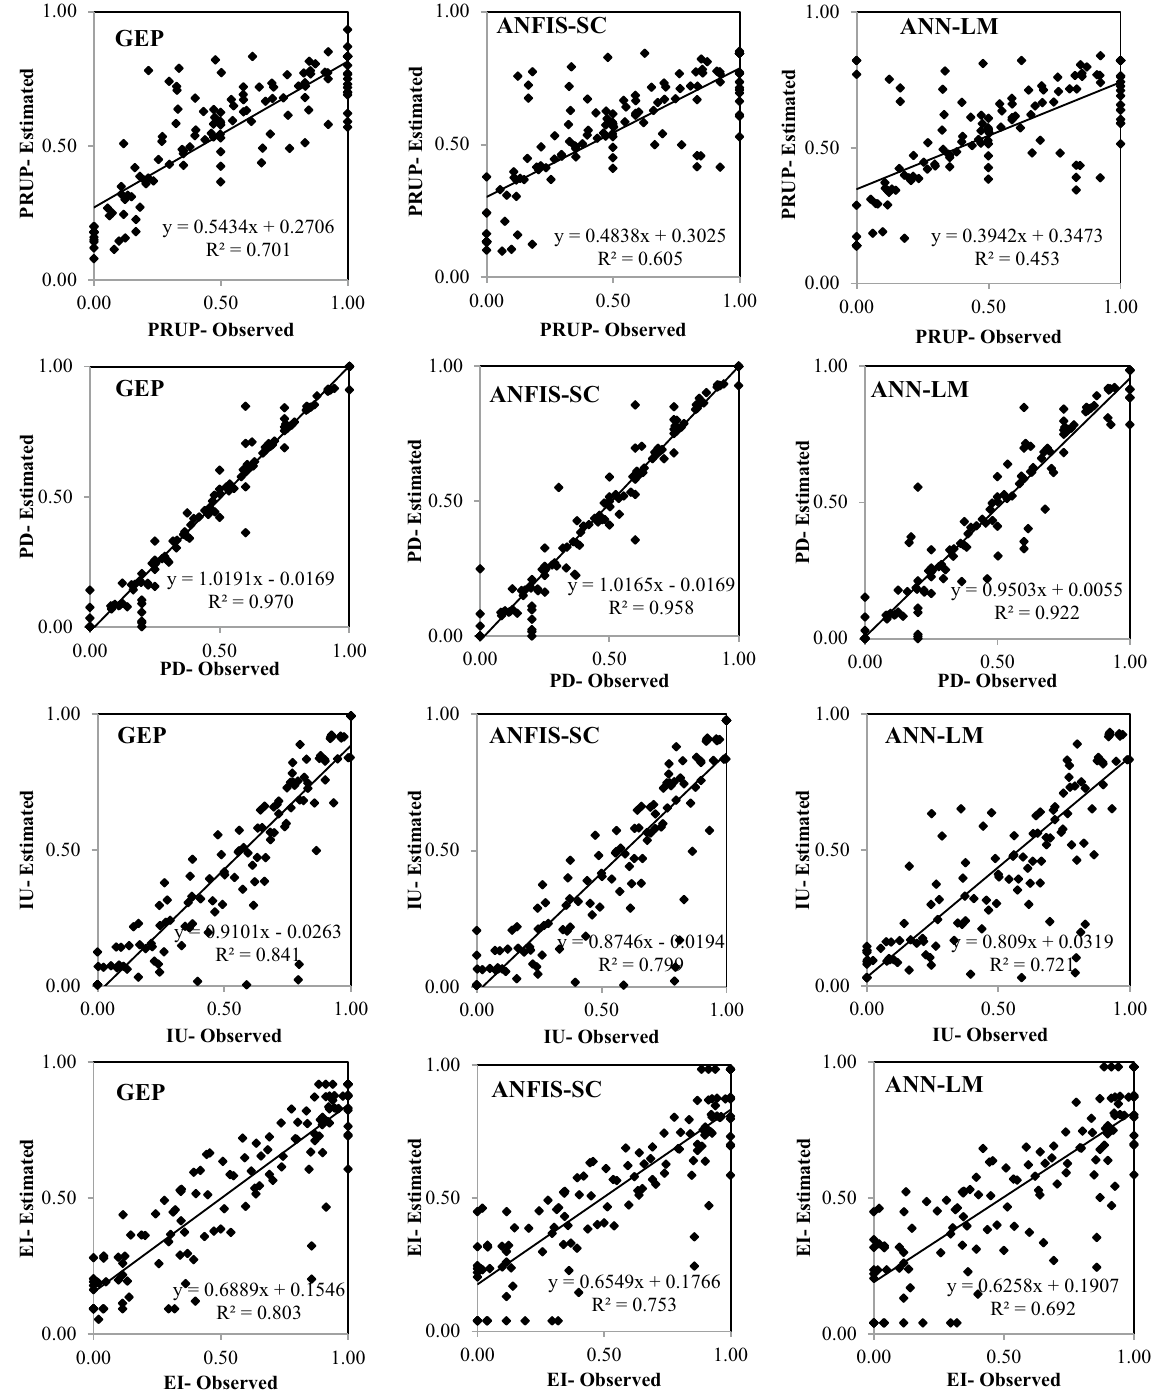
Figure 7. Observed and estimated social parameters during the testing period in